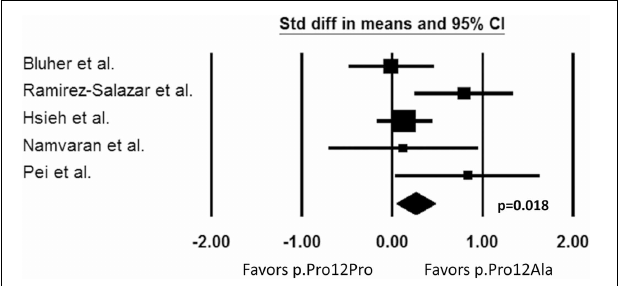
FIGURE 2 | Change in fasting plasma glucose from baseline. Comparison of PPARG p.Pro12Pro genotype vs. p.Pro12Ala carriers (Std diff in means, standard difference in means; 95% CI, 95% confidence